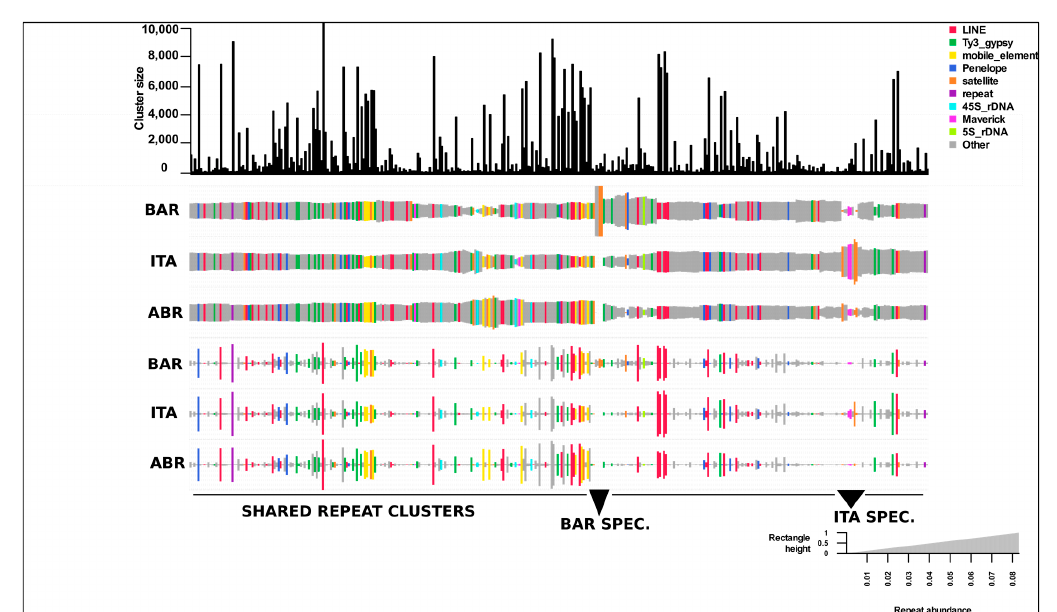
Figure 2. A comparative repeat graph of genus Calliptamus species. A bar plot on the top of the graph depicts the sizes (numbers of reads) of individual top clusters. The size of the rectangle is equal to the number of reads in a cluster for each species. Hierarchical clustering was used to sort the Clusters and species. The final annotation of the clusters is used to color unique rectangles. Species abrreviated with codes as C. barbarus; BAR, C. italicus; ITA, C. abbreviatus; ABR.